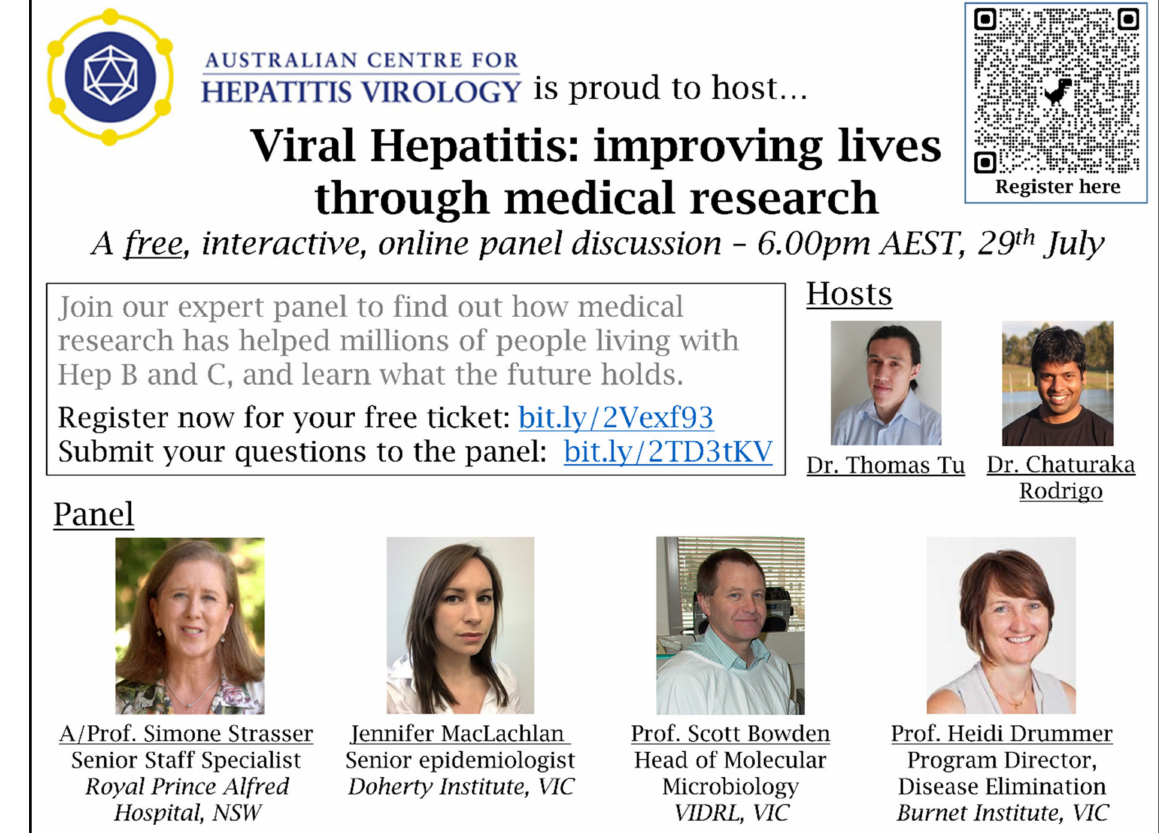
Figure 1. Poster designed by ACHV to advertise the discussion panel